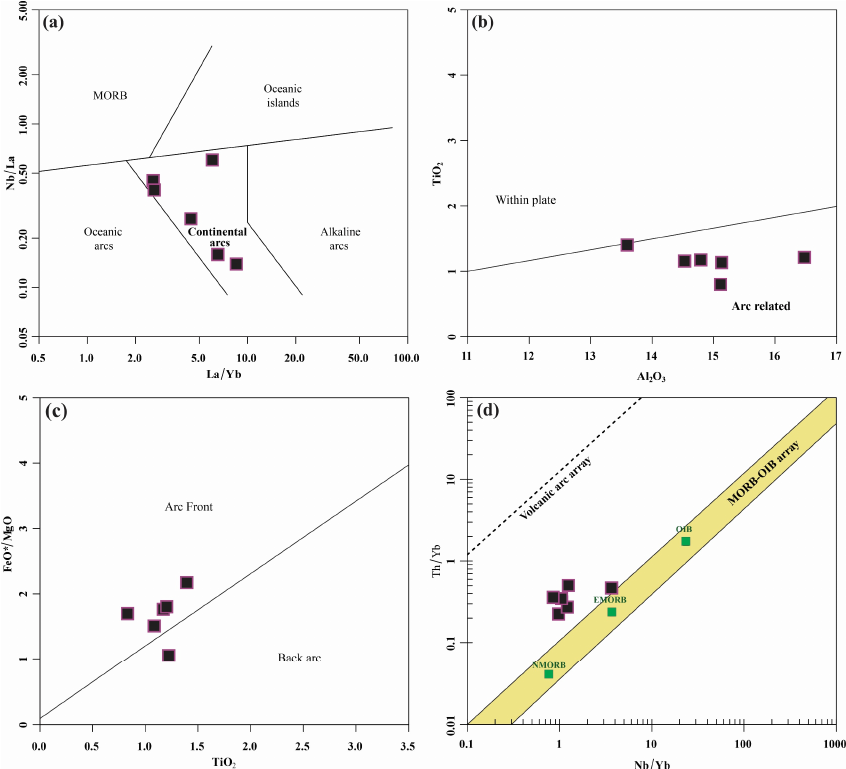
Figure 12. ( a ) La/Yb-Nb/La diagram [57]; ( b ) TiO 2 vs. Al 2 O 3 diagram [58]; ( c ) FeO*/MgO vs. TiO 2 [59]; ( d ) Th/Yb vs. Nb/Yb diagram [63].